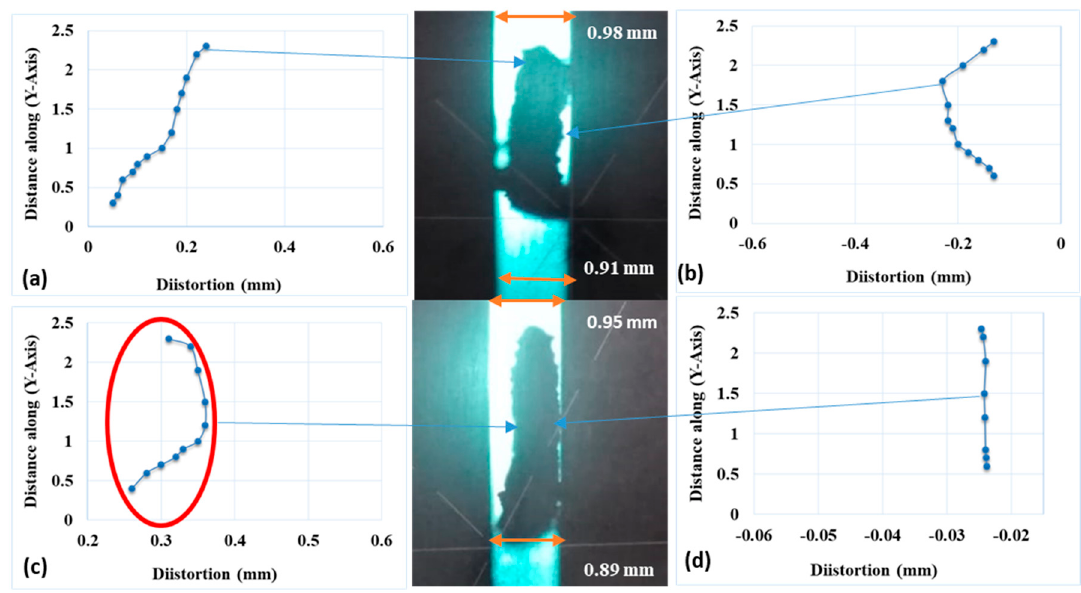
Figure 20. Distortion along the Y-axis for the 50-layers (all sides) for 2.5 mm parts. ( a ) Left side from the front view. ( b ) Right side from the front view. ( c ) Left side from the bottom view. ( d ) Right side from the bottom view